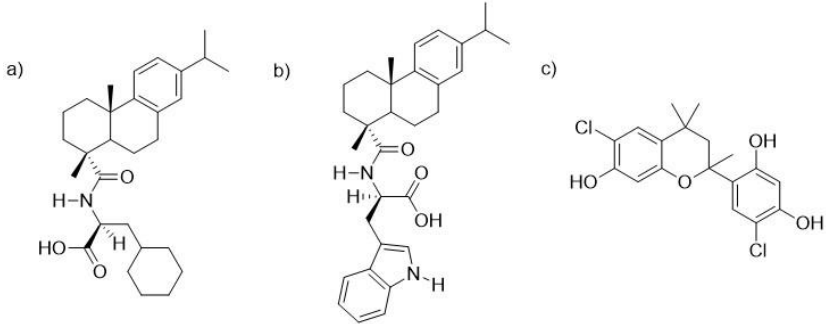
Figure 1. Chemical structures of the two dehydroabietic acid (DHA) derivatives, ( a ) N -(abiet-8,11,13- trien-18-oyl)cyclohexyl-L-alanine and ( b ) N -(abiet-8,11,13-trien-18-oyl)-D-tryptophan, coded DHA1 and DHA2 , as well as the flavan derivative ( c ), 6-chloro-4-(6-chloro-7-hydroxy-2,4,4- trimethylchroman-2-yl)benzene-1,3-diol, coded FLA1